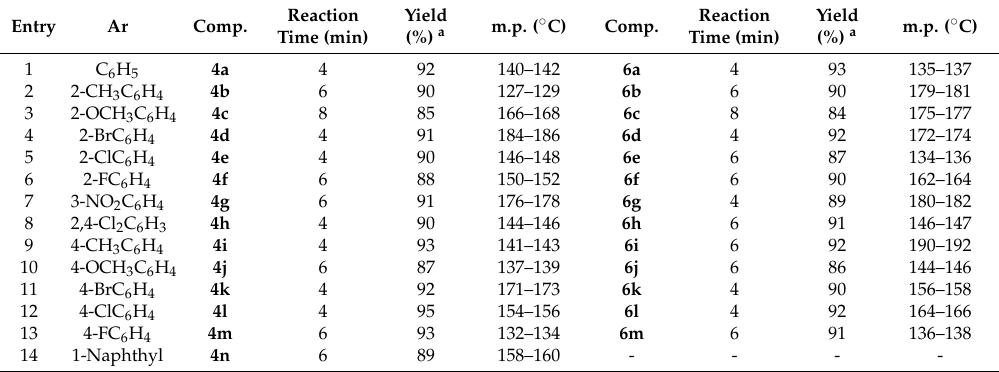
Table 1. Reaction time, yield and melting point of diazaheptacycles 4a – n and 6a – m .